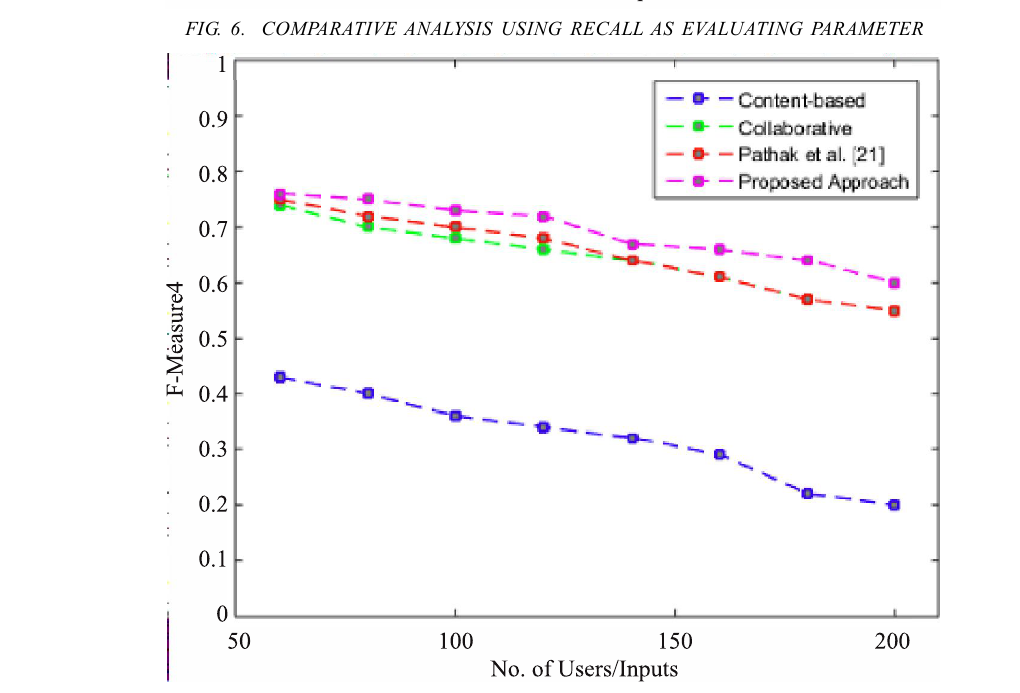
FIG. 7. COMPARATIVE ANALYSIS USING